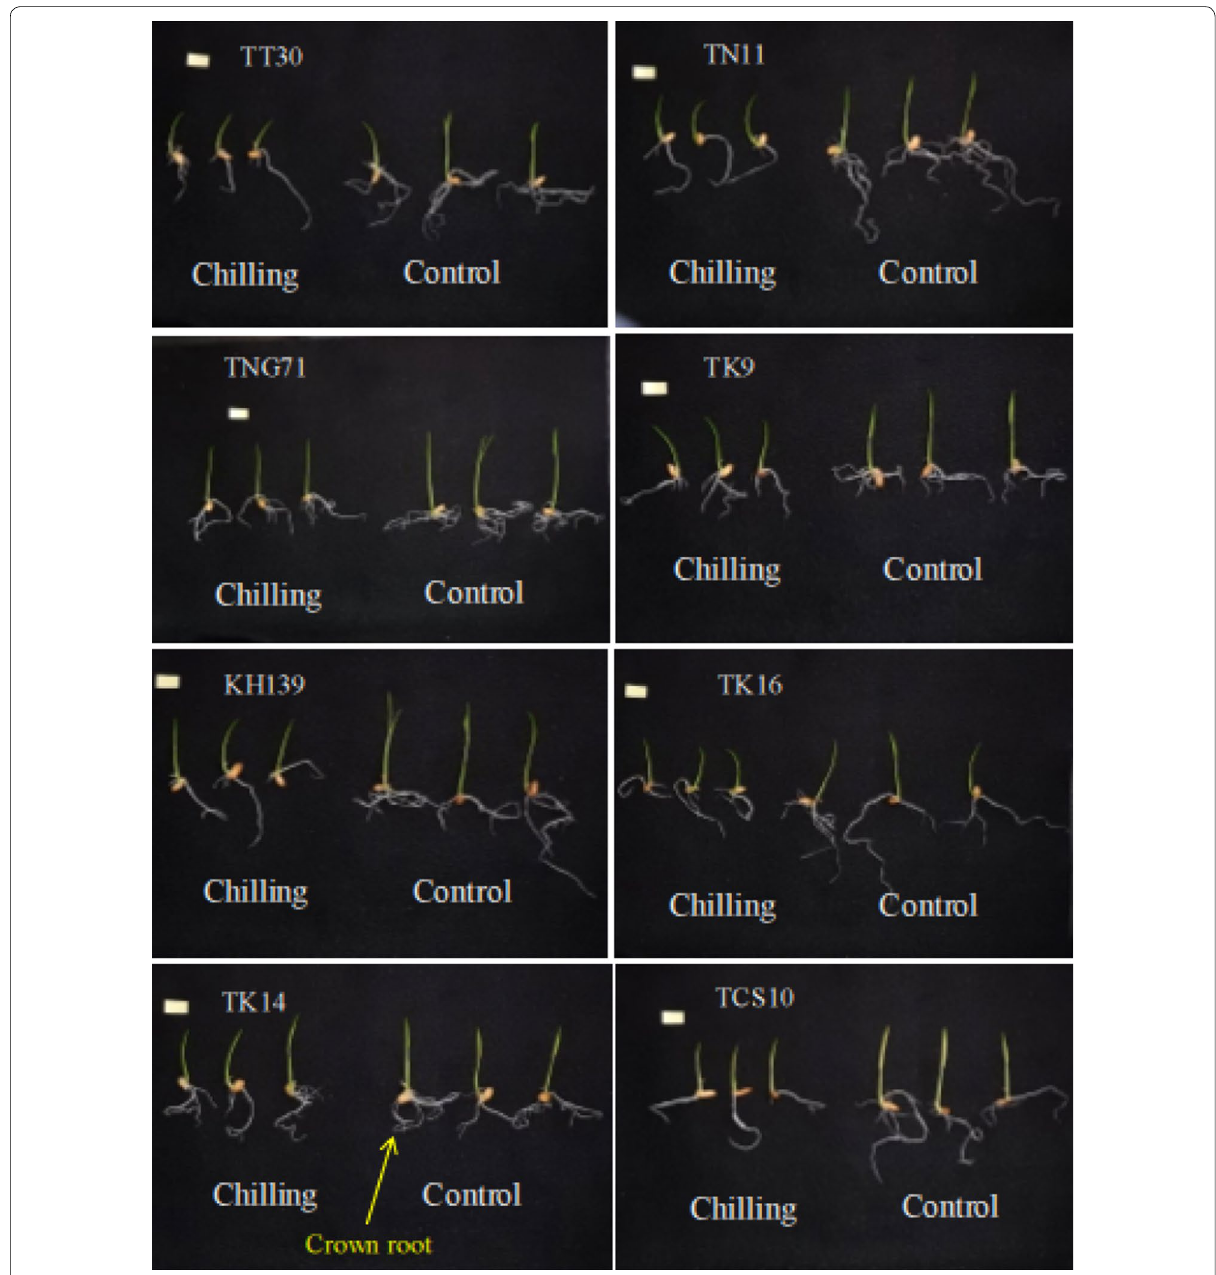
Fig. 1 The cold stress response of rice seedlings. The temperature was set at 15 °C for cold treatment and 27 °C for control. After 4 days of treatment, the temperature was adjusted to 27 °C for 3 days before harvesting. Bar